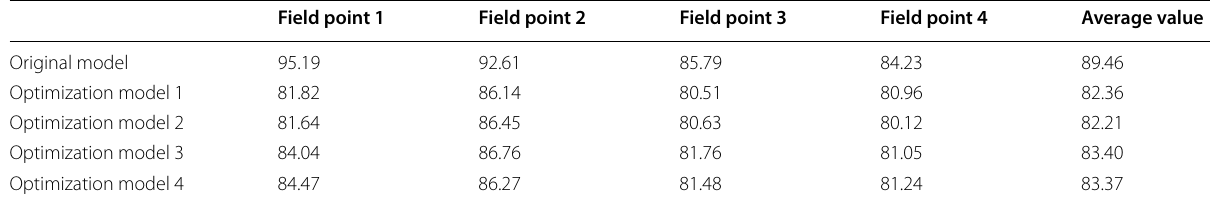
Table 4 Effective sound pressure level of radiated noise at each field point before and after topology optimization design of single- stage gearbox